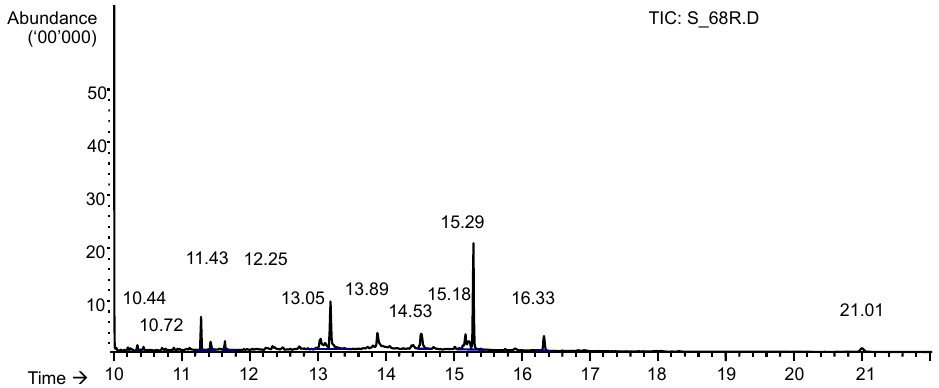
Figure 1. The graph shows gas chromatography-mass spectrometry (GC-MS) chromatogram for Fraction 8, of which 9 out of 10 identified compounds were further investigated to determine antimycobacterial activity. Samples were analyzed using Agilent 7890 A GC system with constant flow rate of helium gas at 2 mL/min, 1 µ L of injection volume, electron ionization system with 70 eV of ionizing energy, with inlet and detector temperature of 280 ◦ C. Table 2. Characterization and antimycobacterial activity of active compounds detected in OPF n -hexane partition Fraction 8. Retention